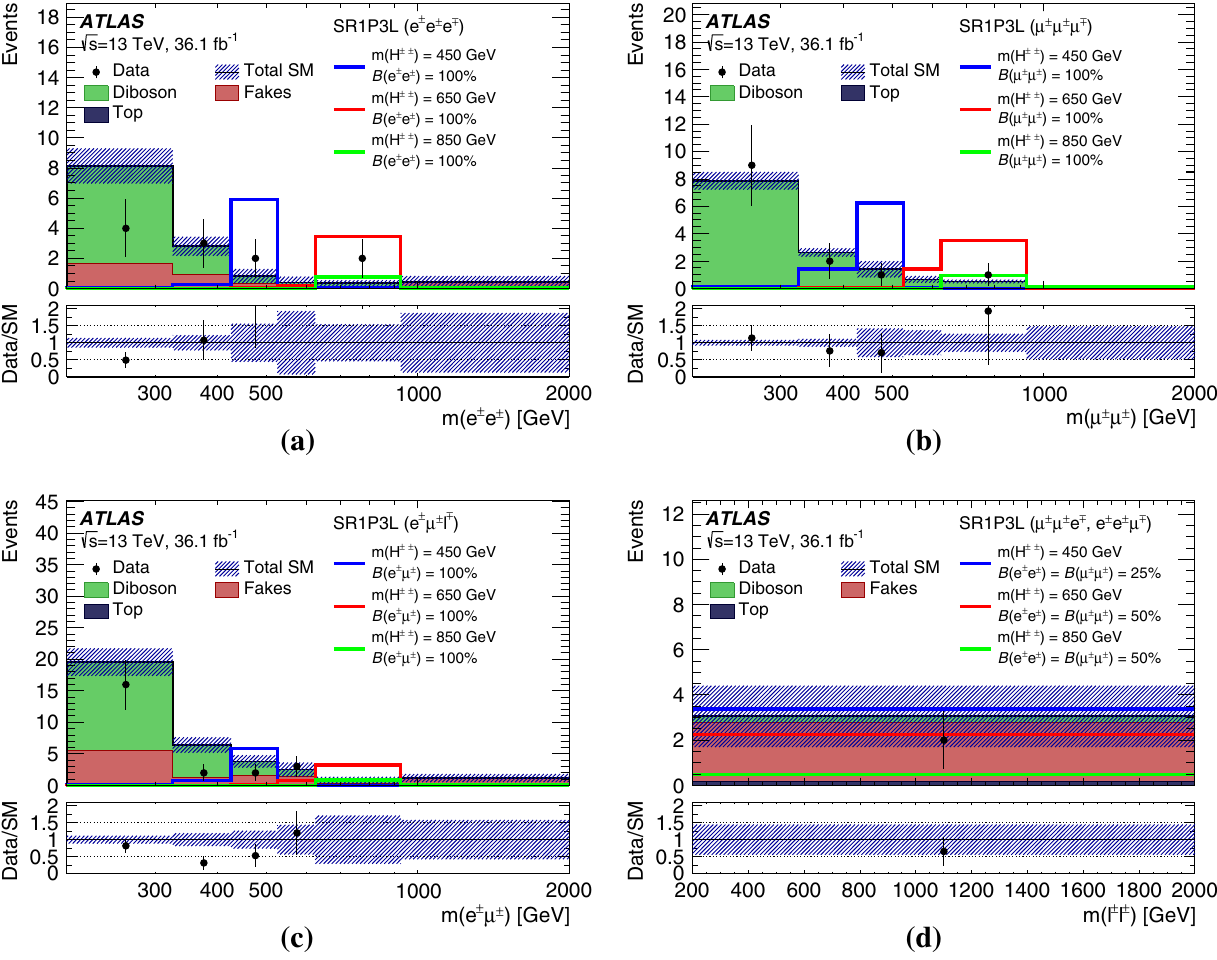
Fig. 9 Distributionsof m ((cid:3) ± (cid:3) ± ) inthree-leptonsignalregions,namely a the three-electron SR (SR1P3L), (b) the three-muon SR (SR1P3L), ( c ) the SR1P3L with an electron–muon same-charge pair ( e ± μ ± (cid:3) ∓ ), and (d) the SR1P3L with a same-flavour same-charge pair ( e ± e ± μ ∓ or μ ± μ ± e ∓ ). The hatched bands include all systematic uncertainties post-